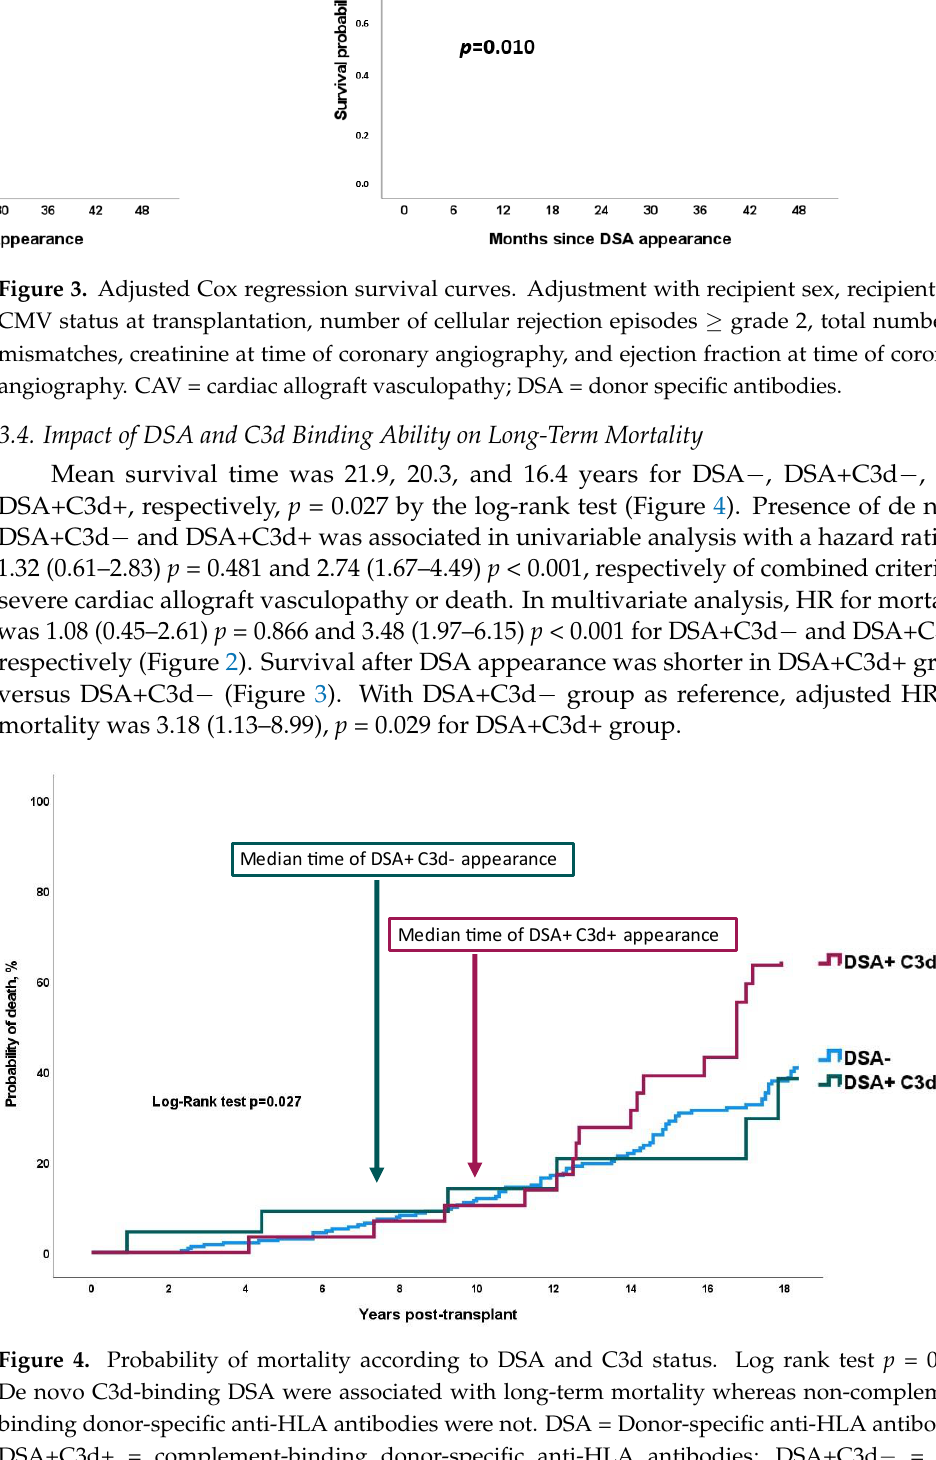
Figure 2. Association between outcomes and DSA and C3d status. Hazard ratio using time depend- ent Cox regression multivariate model with recipient sex, recipient age, total number of mismatches, number of rejection episodes ≥ grade 2, CMV mismatch, creatinine, and ejection fraction at time of coronary angiography. ( A ) severe cardiac allograft vasculopathy or mortality; ( B ) mortality.